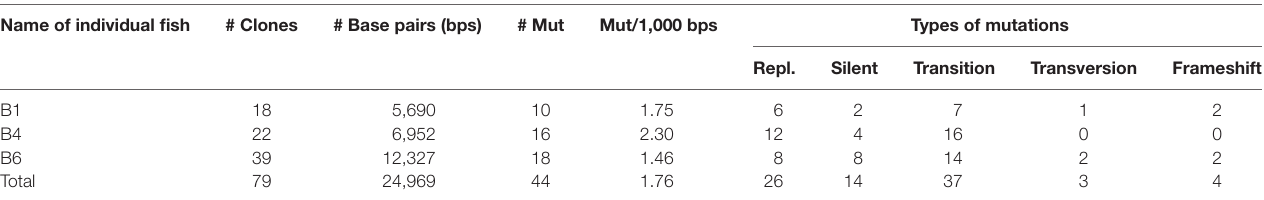
TaBle 2 | C α -mutations in 79 cDNA clones of three Ballan wrasse individuals. name of individual fish # Base pairs (bps) Mut/1,000 bps